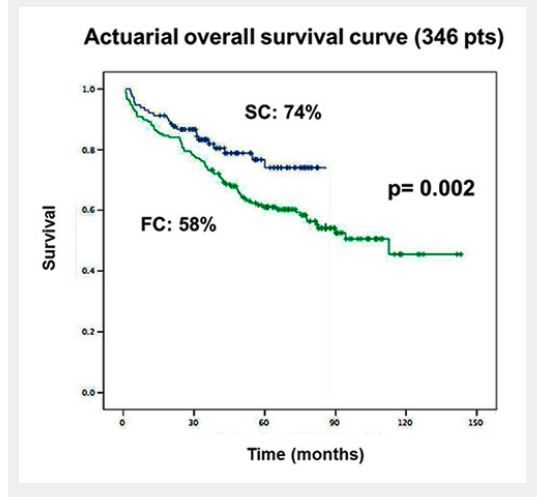
Actuarial overall survival (346 patients); SC: blue; FC: green.